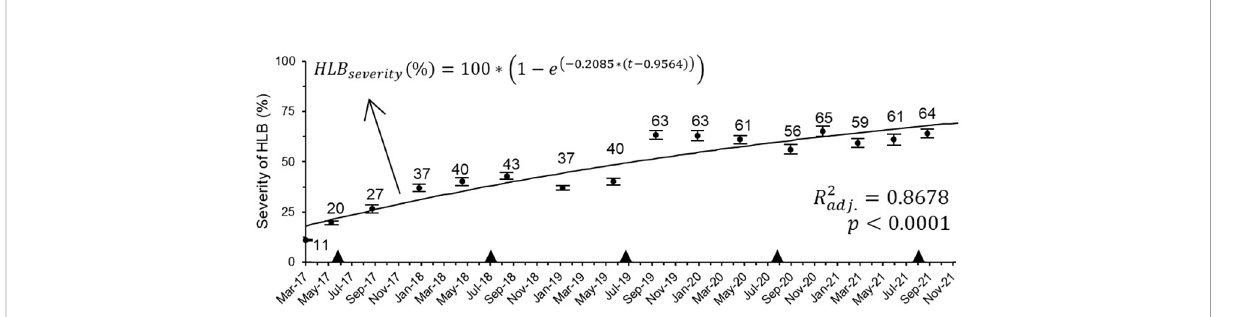
FIGURE 3 Progress of HLB severity on 5-year-old ‘ Femminello ’ lemon trees (n = 34; 1 st assessment = 24/03/17). The continuous black line is the estimated progress based on the given model equation. The black triangles indicate the time when the trees were pruned (top or lateral), normally within 30 days after the main harvest date of each season.